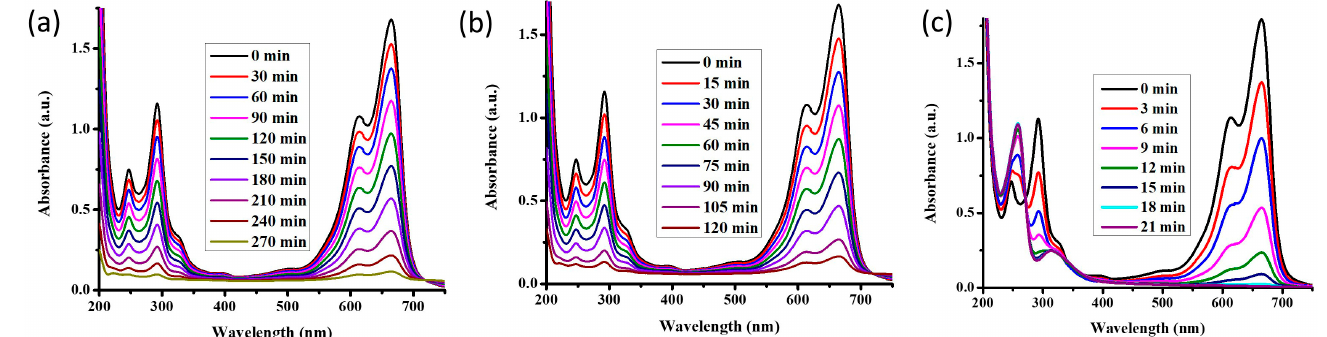
Figure 4. Catalytic and photocatalytic degradation/reduction of MeBl on Cu(II)–[ABA–MA] MOF; ( a ) in the absence of both sunlight and NaBH 4 , ( b ) in the presence of sunlight but the absence of NaBH 4 , ( c ) in the presence of NaBH 4 but the absence of sunlight.